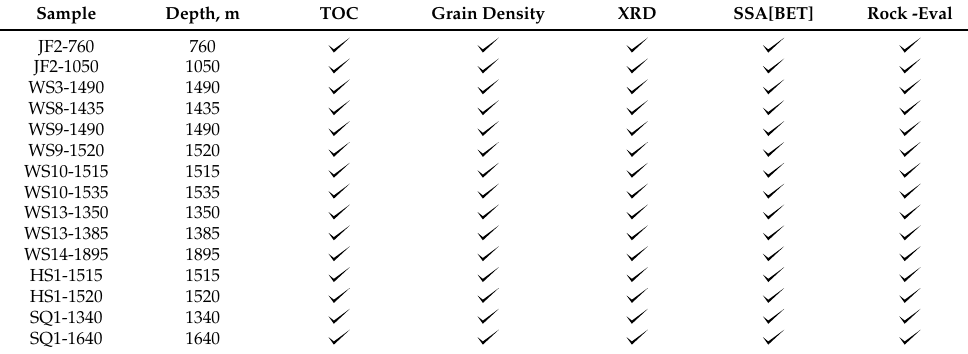
Table 1. A list of examined